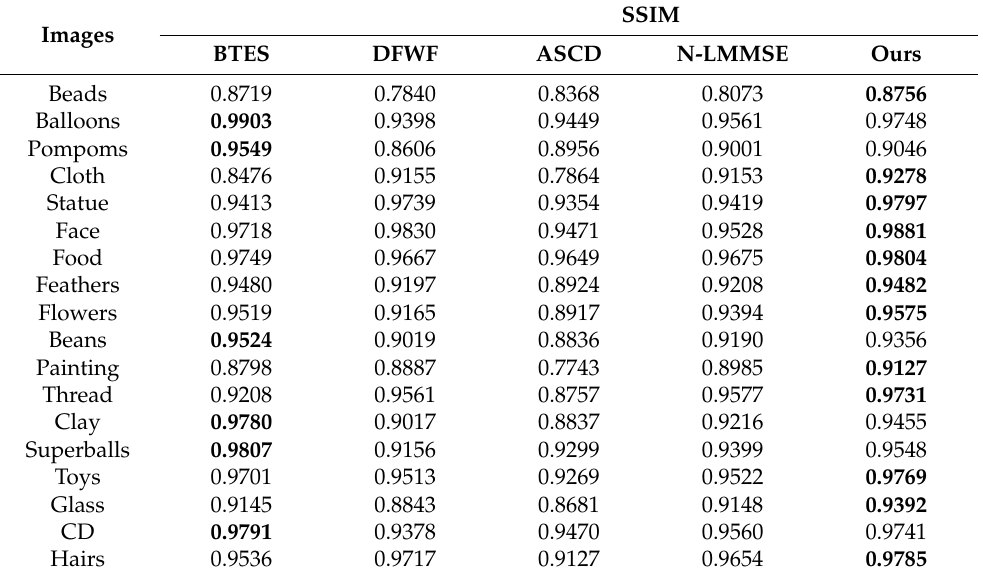
Table 3. The SSIM average results of demosaicking